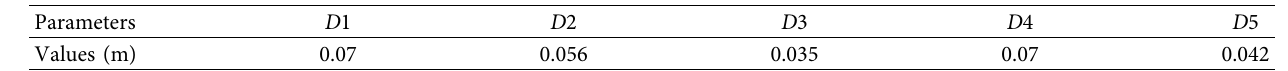
Table 2: Diameters of the